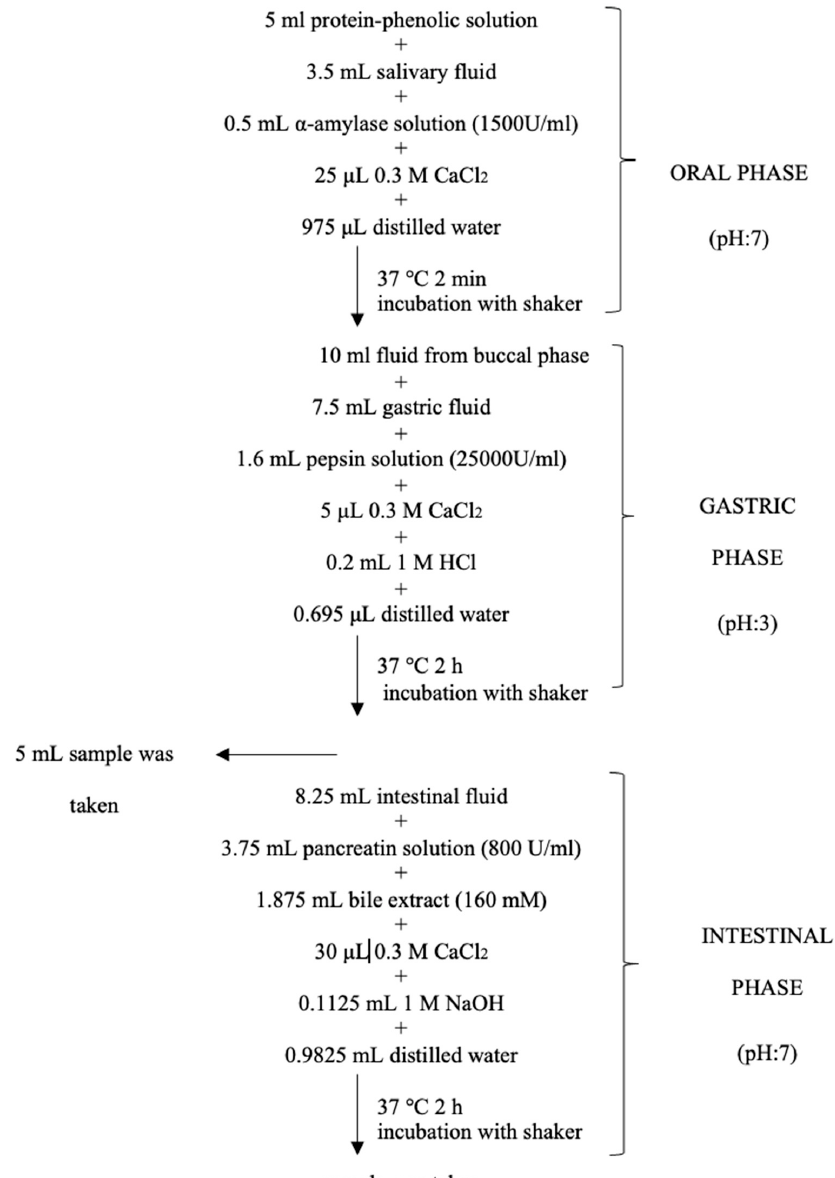
Figure 1. Flow diagram of simulated in vitro gastrointestinal digestion; pH adjustment was made with 0.1 M HCl or 1 M NaOH for each phase.